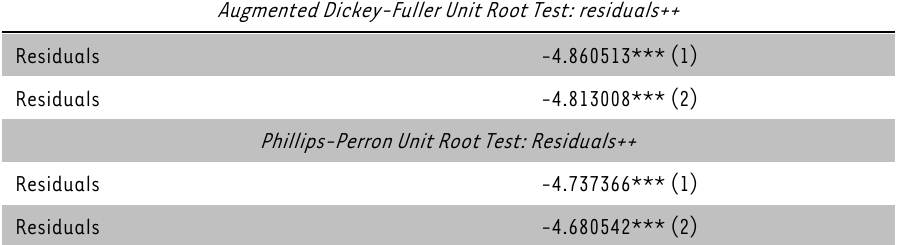
TABLE 4: Unit Root test on residuals-positive component of oil